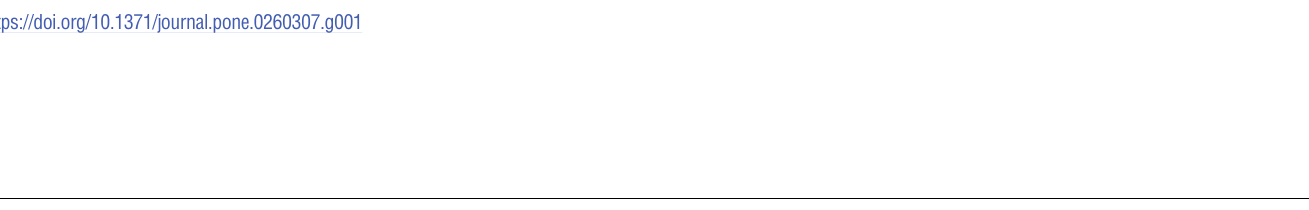
PLOS ONE | https://doi.org/10.1371/journal.pone.0260307 November19, 2021 4 /